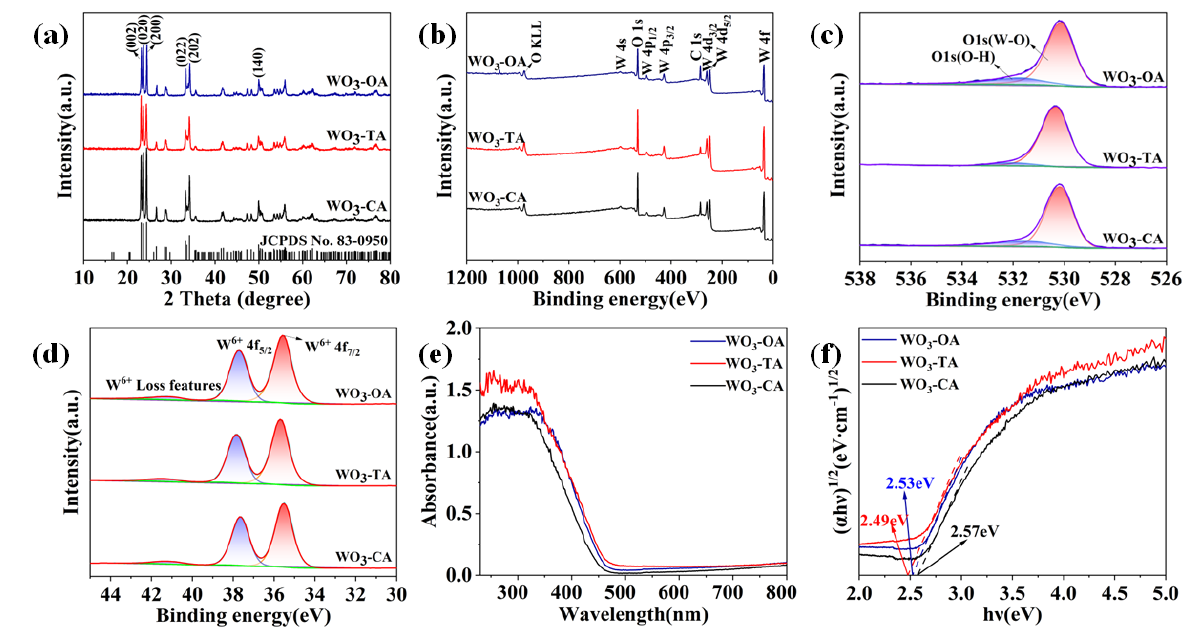
Figure 1. ( a ) XRD patterns, ( b ) The full-scale XPS spectra, ( c ) O1s, ( d ) W4f, ( e ) UV-vis absorption spectra of different samples, ( f ) Plots of the (ah ν ) 1/2 vs. photon energy (h ν ) for WO 3 samples.